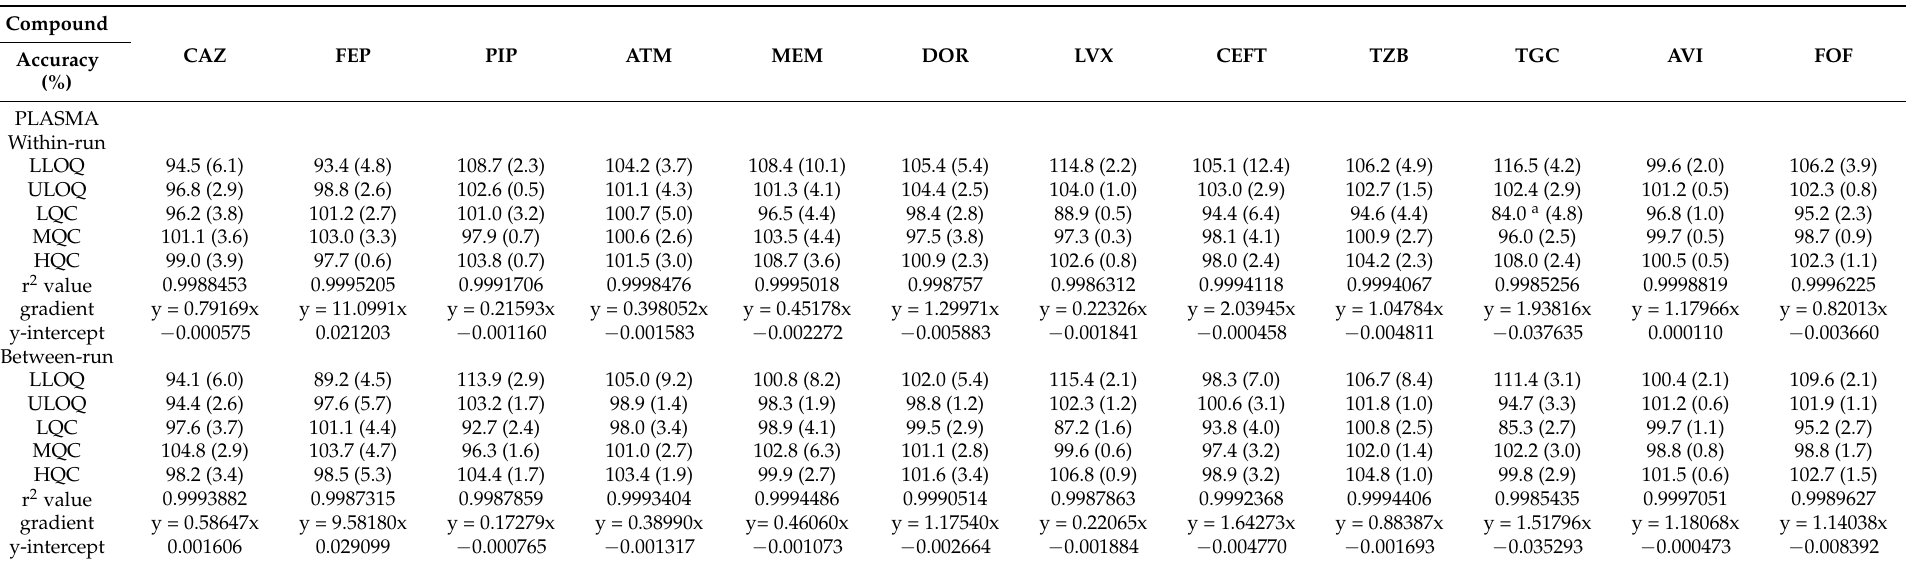
Table 2. Within- and between-run accuracies of 12 compounds in plasma for LLOQ, ULOQ, LQC, MQC and HQC.